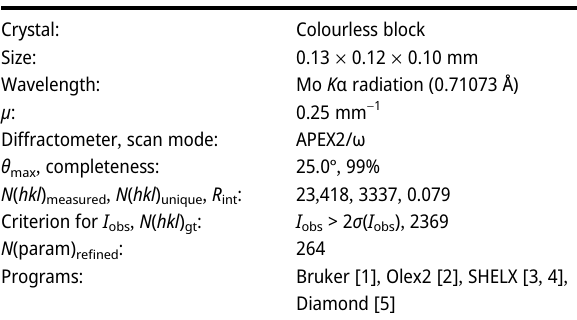
Table  : Data collection and